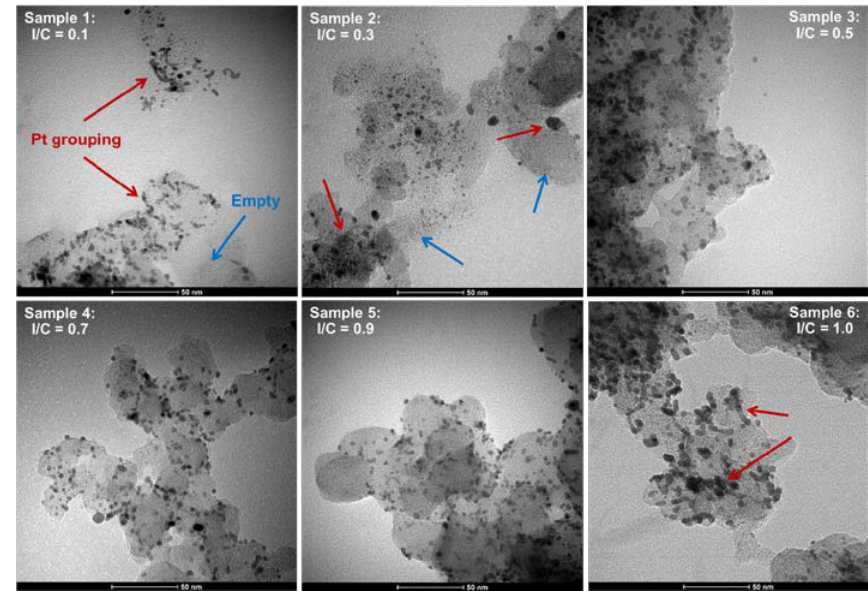
Figure 2. TEM images showing evolution of platinum distribution as a function of varying ratios of PTFE binder to carbon support material (I/C). Red arrows indicate areas where platinum has the grouped whereas blue arrows indicate areas where platinum is absent from the